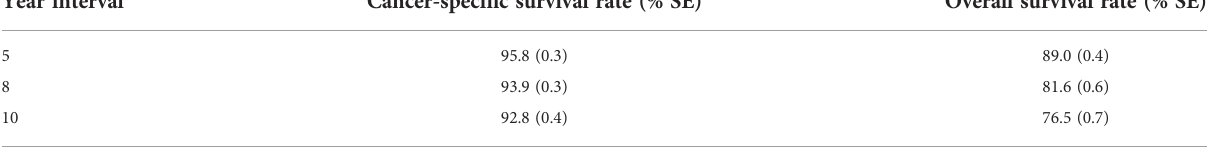
SE indicates standard error of the